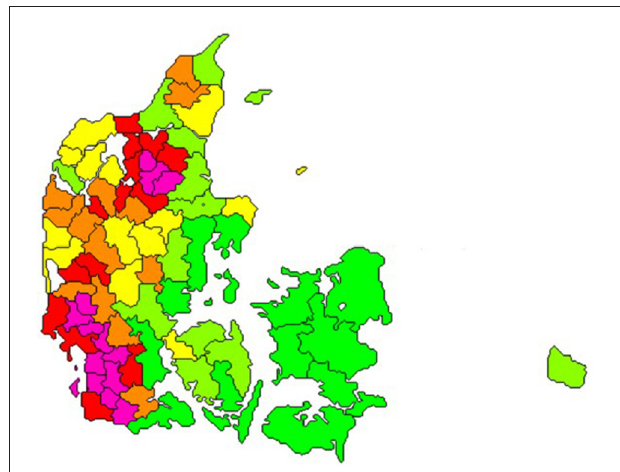
FIGURE 1 | Number of cattle per square kilometre in all herd types in Denmark on the 23rd of February 2021. Bright green: areas with up to 19 cattle/km 2 , light green: > 19–29, yellow: > 29–44, orange > 44–57, red: > 57–86 and pink: areas with more than 86 cattle/km 2 . The size and shape of the geographical areas were generated to represent approximately equal number of cattle. (Source: SEGES, Aarhus,